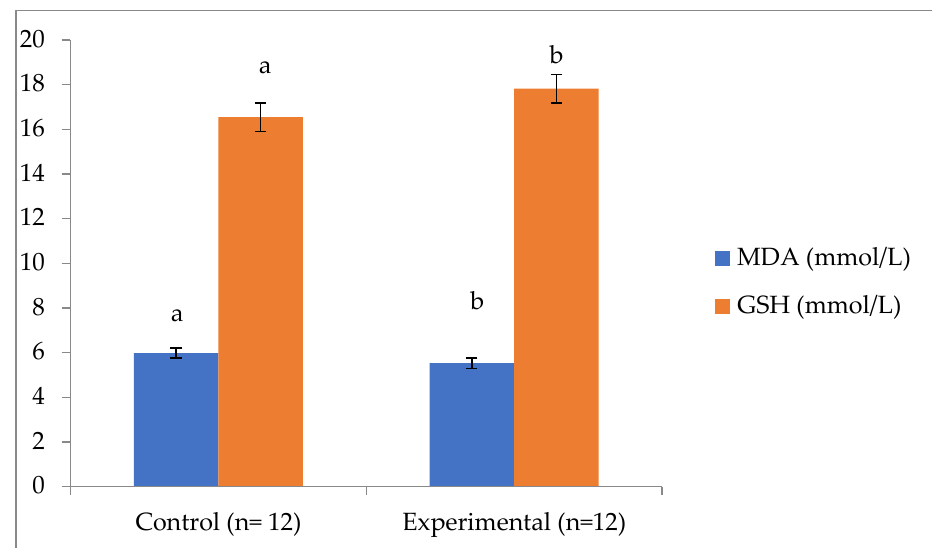
Figure 1. Antioxidant profile of control and experimental SOD-rich melon supplement group of Tuj lambs. MDA= malondialdehyde; GSH = glutathione; different letters (a,b) on error bars indicate significant difference at p < 0.05 within control and experimental group.